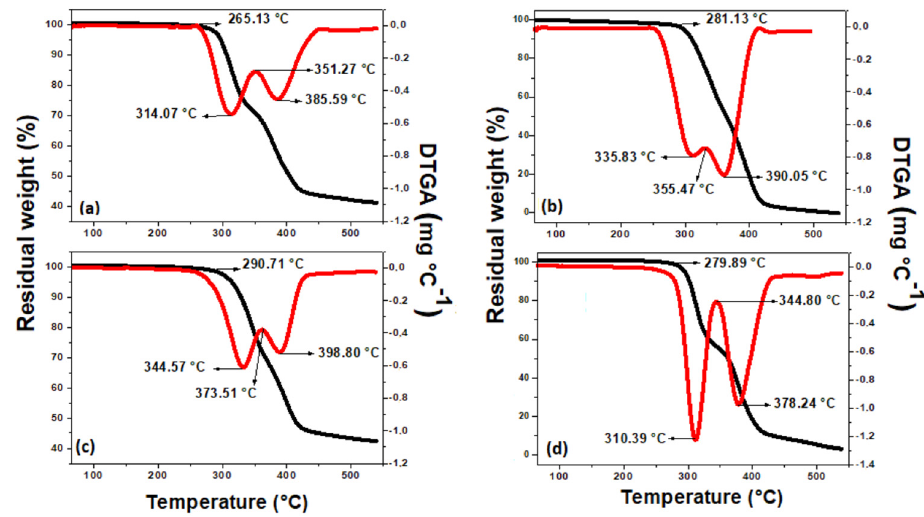
Figure 7. Thermogravimetric curves (TGA) and derivative of degradation curves (DTGA) of pure ( a ) PBAT/PLA polymeric fibers; ( b ) with 10% TiO 2 —R; ( c ) with 1% Fe 3 O 4 ; and ( d ) with 10% TiO 2 — R + 1% Fe 3 O 4